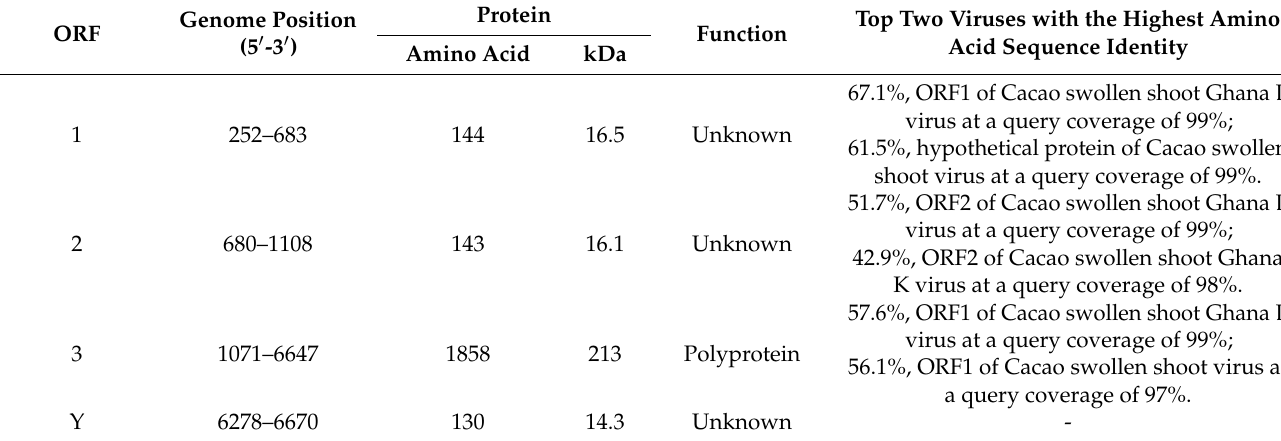
Table 2. Putative open reading frames (ORF) in the ChTBV1 genome